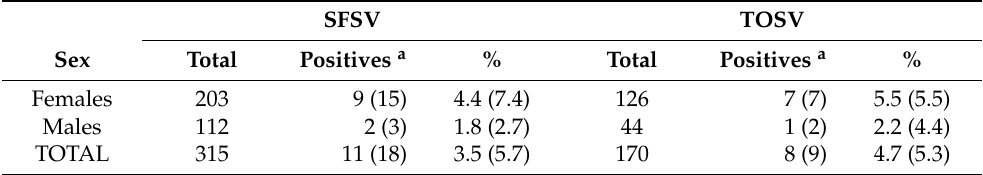
Table 3. Serological results by